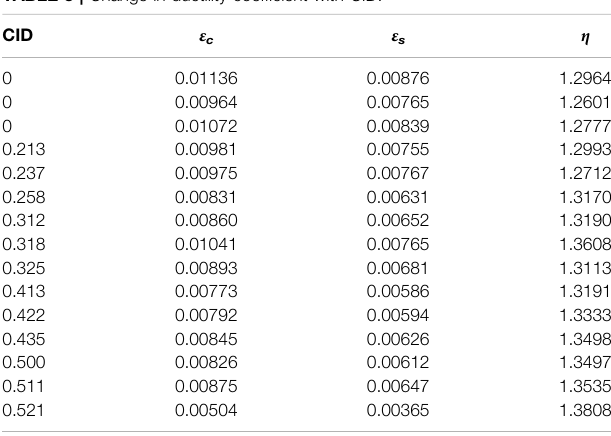
TABLE 3 | Change in ductility coef fi cient with CID.